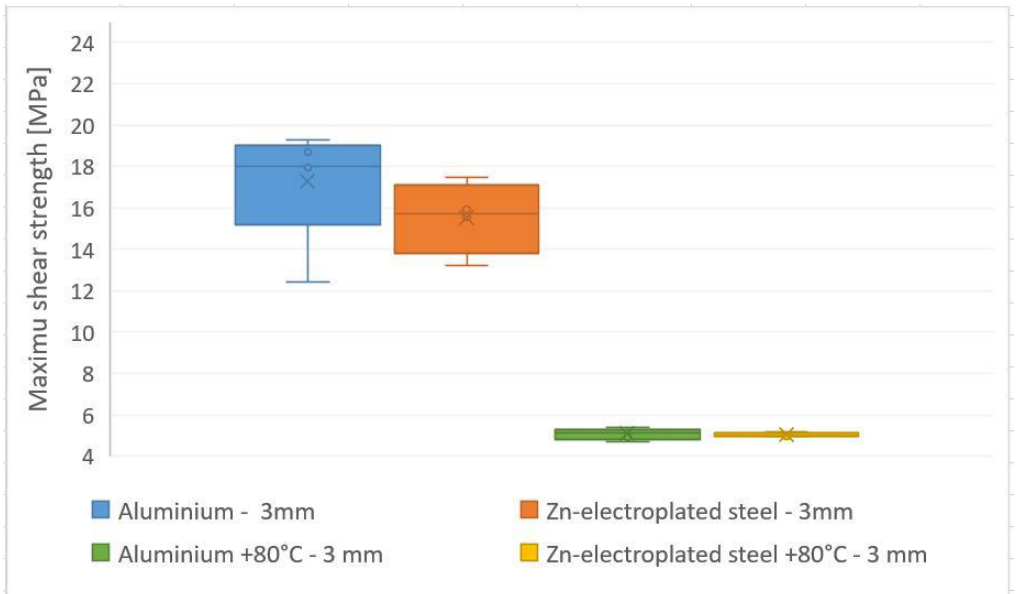
Fig. 8 Maximum shear strength for specimen at room and elevated